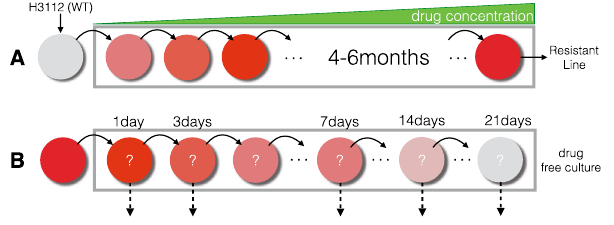
Figure 5. Experimental design diagram. Panel (A) depicts the evolution of resistance by exposure for 16 weeks to drug to create a drug-resistant population and in (B) the population is removed from drug